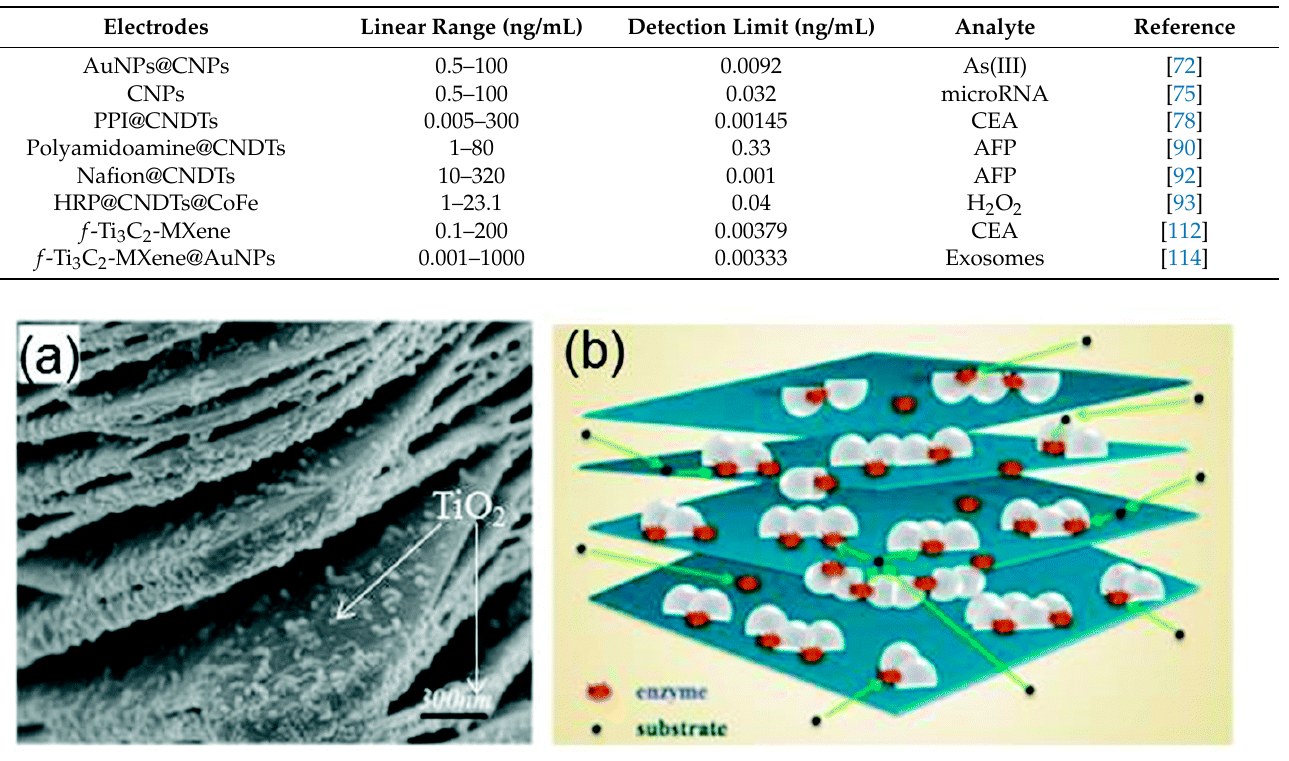
Table 2. Reveals the summary of various carbon nanomaterials used in the development of biosen- sors for various analytes.